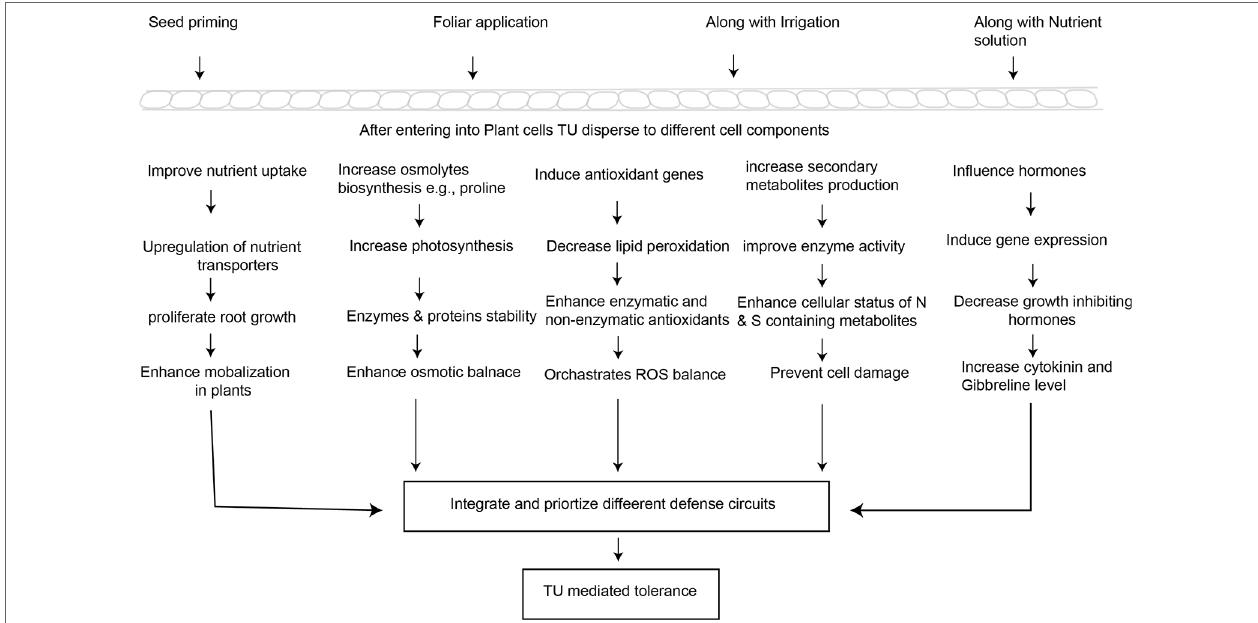
FIGURe 2 | Simplified pattern indicating the potential mechanisms involved in TU-mediated abiotic stress tolerance and crop yield stability.